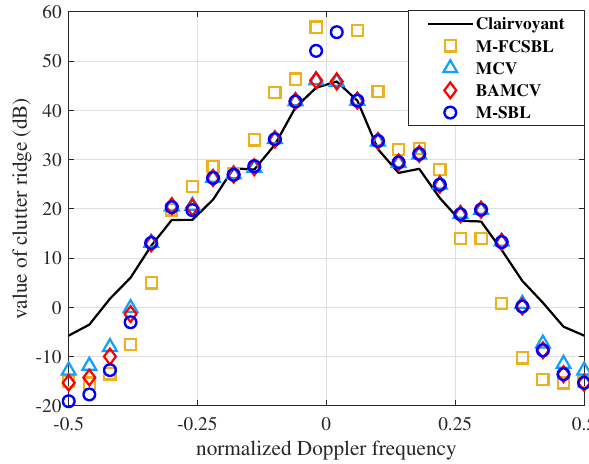
Figure 7. Analysis of clutter ridge estimated by different methods.